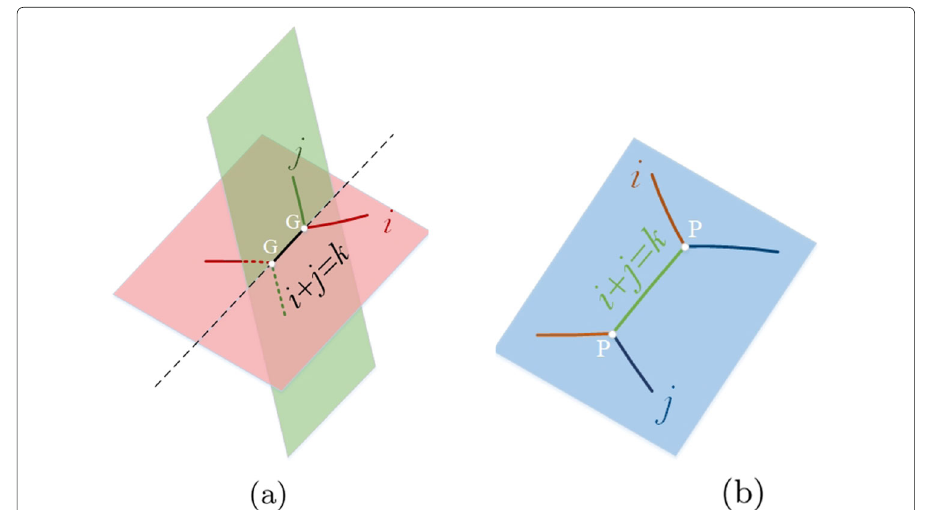
Fig. 6 a Direct glissile junction formation on slip system k from dislocations on slip systems i and j . Slip system i shares its slip plane with slip system k but not with slip system j , e.g., A2 + C3 = A6. Both end nodes for the new glissile link ( k ) are G-type. b Coplanar junction formation on slip system k from dislocations on slip systems i and j . All three slip systems, i , j , k are on the same slip plane, e.g., A2 + A3 = A6. Both end nodes for the new coplanar link ( k ) are